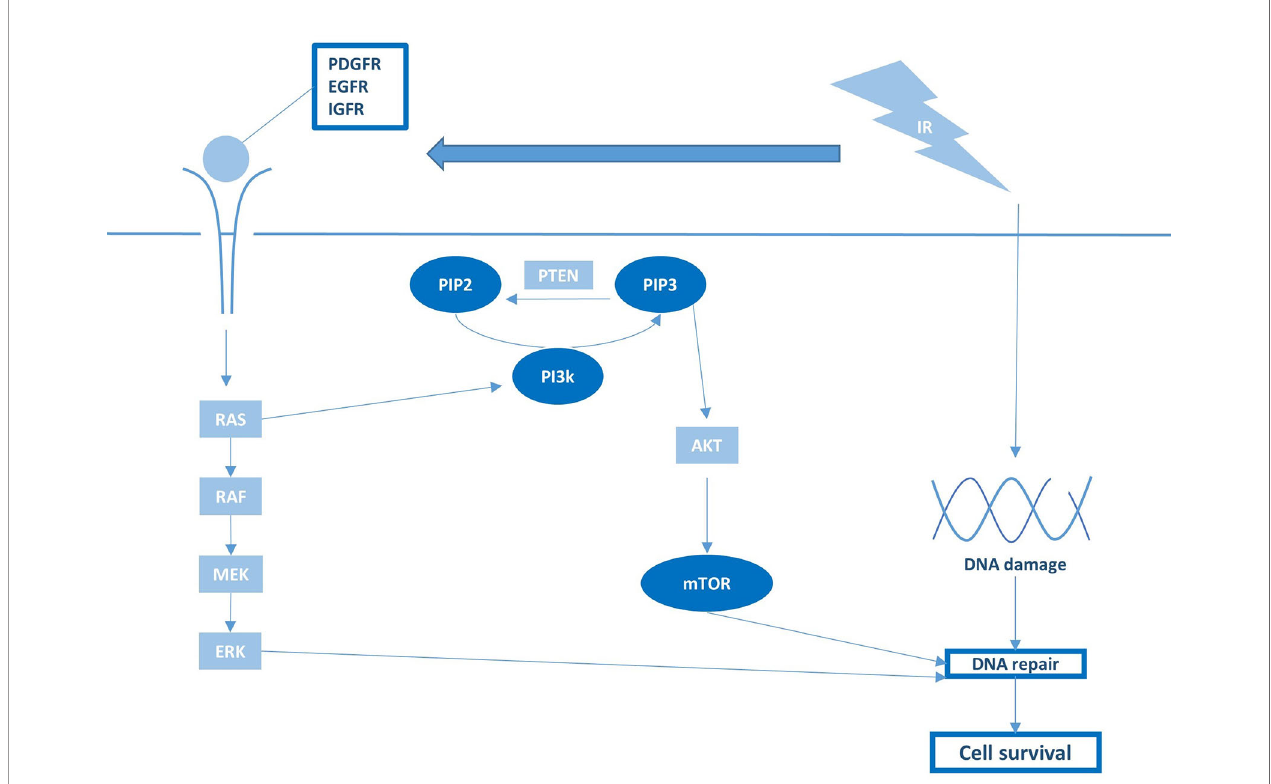
FIGURE 4 | Growth factor receptor activation and downstream PI3K/mTOR signaling are pivotal regulators of RT sensitivity and pHGG